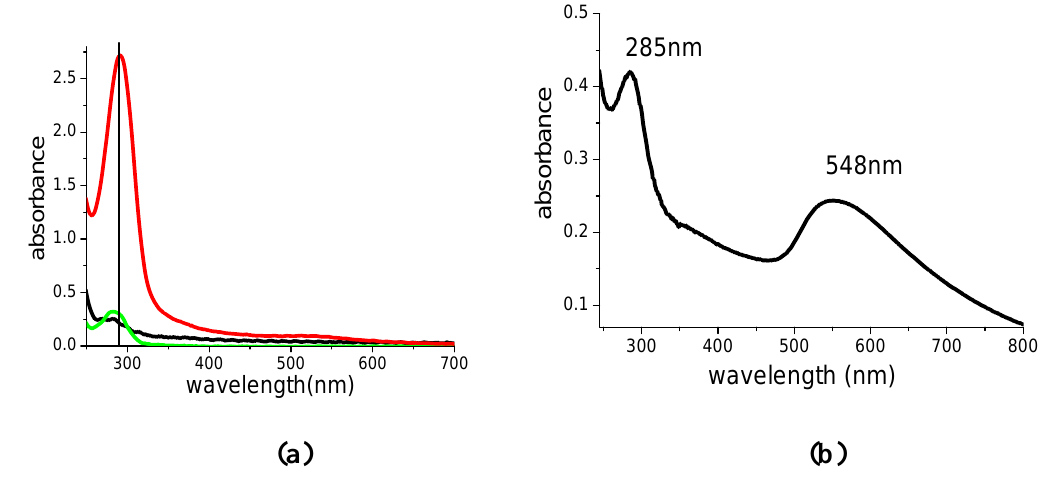
Figure 6. (a) UV-Vis spectra of PAMAM G5 in water multiplied by a factor of 10 (black curve), PAMAM G5 in water after irradiation with 532 nm, 15 mJ, 10,000 shots (green curve) and PAMAM G5-capped AuNPs obtained with 532 nm, 15 mJ, 10,000 shots (red curve). OPL = 1 cm (b) UV-Vis spectra of a suspension of PAMAM G5-capped AuNPs obtained by spontaneous reduction of a 1 mM solution di HAuCl in water. OPL = 1